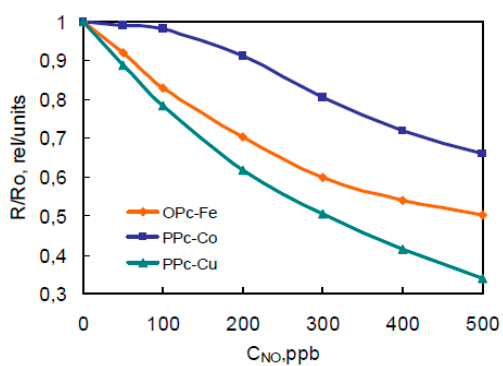
Figure 3. Typical resistance dependence on NO concentration in air at 100 о C.